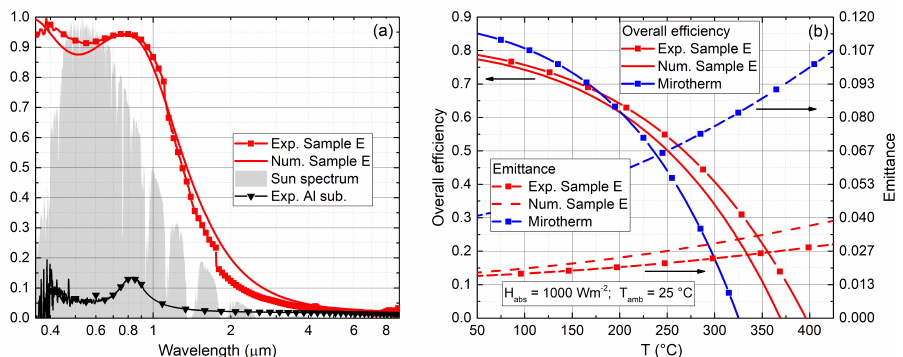
Figure 7. ( a ) The experimentally measured (red line with square markers) and numerically simulated (red line) spectral emissivity of the multilayer E. Black line with diamond markers is the experi- mentally measured spectral emissivity of the aluminum on glass substrate whereas the grey area represents the normalized Sun Spectrum. ( b ) Thermal emittance as function of temperature (right axis). On the left axis is reported the overall efficiency of the collector as function of absorber temper- ature according to Equation (8): H abs = 1000 Wm − 2 , τ glass = 0.91 and T amb = 25 ◦ C, with (cid:101) sub = 0.045 for the industrial aluminum substrate used in